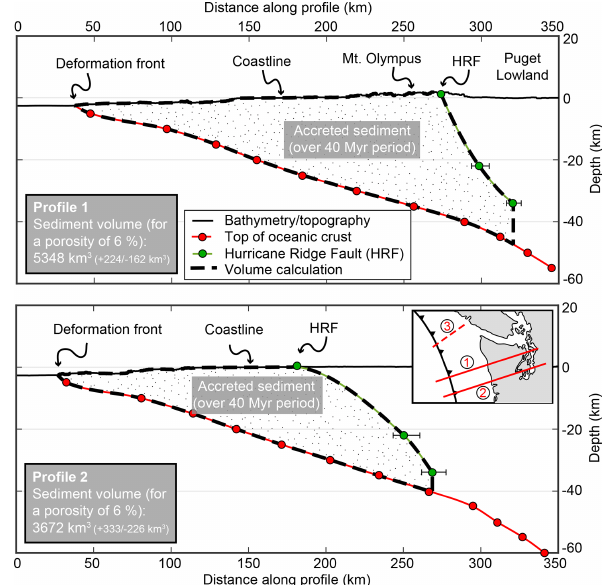
Figure 7. Sediment volumes calculated along two cross sections spanning the Olympic Peninsula (Profile 1 and 2, the vertical exag- geration is 2; see inset for location). For an explanation of the pro- cedure used, see the text. The reported uncertainties for the volume are based on the uncertainties in the position of the Hurricane Ridge Fault (indicated with error bars at the respective symbol). Numbers in the inset correspond to the following: (1) position of Profile 1, (2) position of Profile 2, and (3) position of profile by Davis and Hyndman (1989) referred to in the